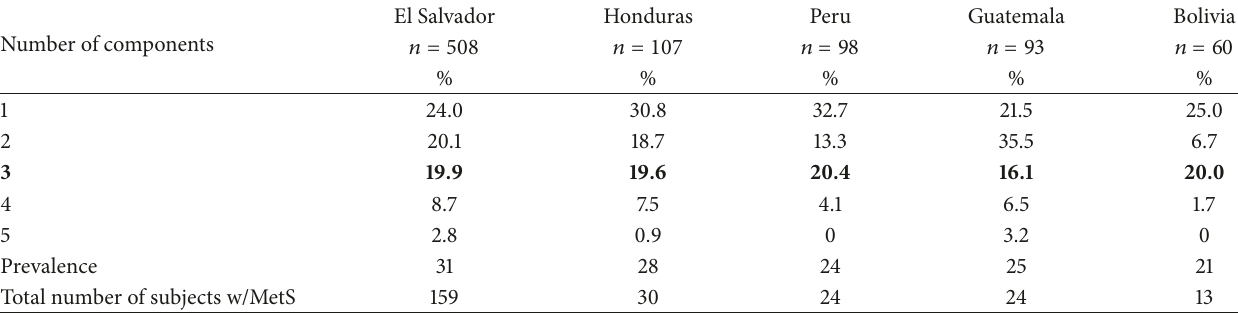
Table 2: Percentage of Central and South Americans meeting Metabolic Syndrome criteria by country of origin ∗ . Number of components